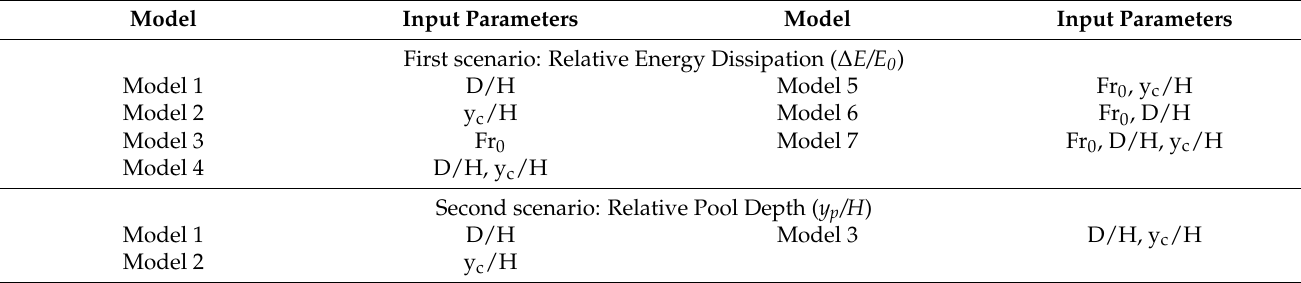
Table 4. Different input combinations applied in the present study.